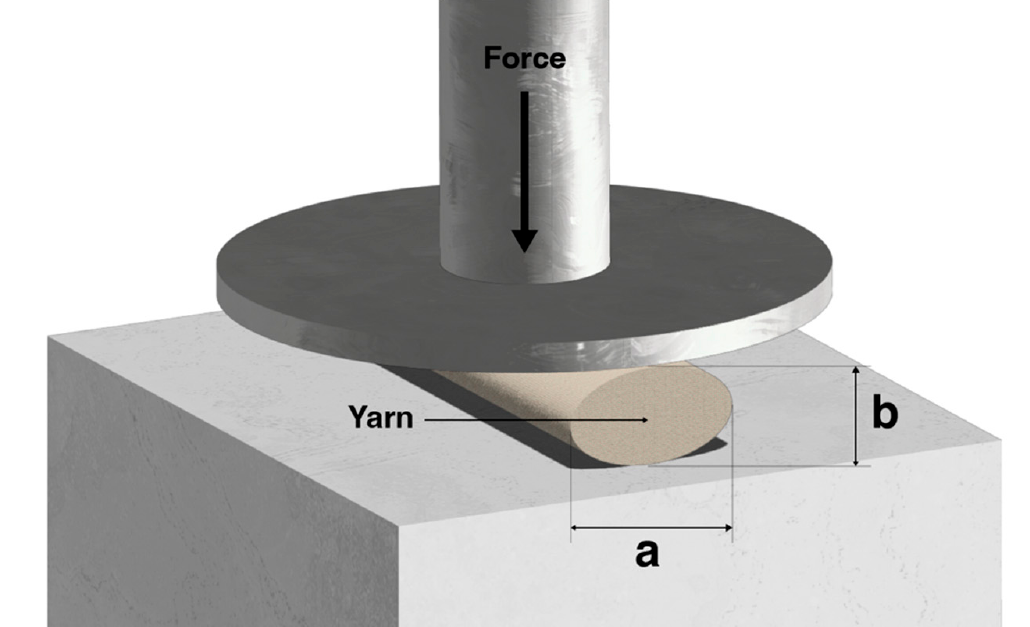
Figure 13. Cross-sectional view of a fibre being compressed, adapted from [32]. In this study, it was possible to make a correlation between the voltage dispersion in terms of average value (CV%) and the knitted fabric’s ability to return to its initial state after compression. Figure 14 shows the output voltage coefficient of variation over the force range tested. In general, it can be understood that a lower voltage CV% for fabric cmeans that the fabric has a higher compression resilience value where it retains its shape.